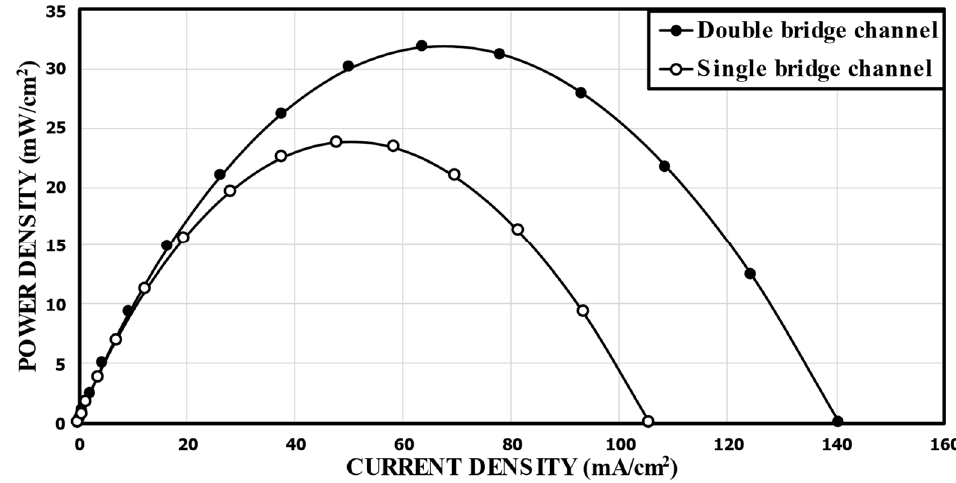
Figure 5. Comparison of predicted performance curves between the single-bridge channel proposed by Montesinos et al. [17] and the reference double-bridge